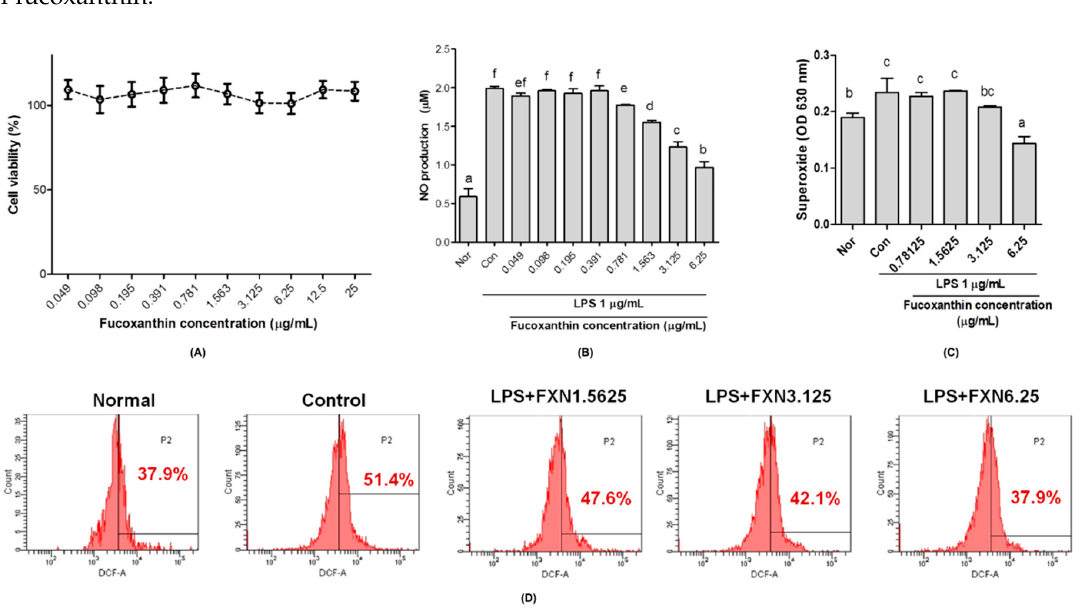
Figure 1. Effects of fucoxanthin (FXN) on ( A ) RAW 264.7 macrophage cells viability, ( B ) nitric oxide, ( C ) superoxide, and ( D ) hydrogen peroxide productions. The cells were stimulated by lipopolysaccharides (LPS, 1 µg/mL). Data are shown as the mean ± S.D. of three independent experiments. The values with different letters (a–f) represent significant differences ( p < 0.05) as analyzed by Duncan’s multiple range test. Normal, unstimulated cells; control, untreated cells.